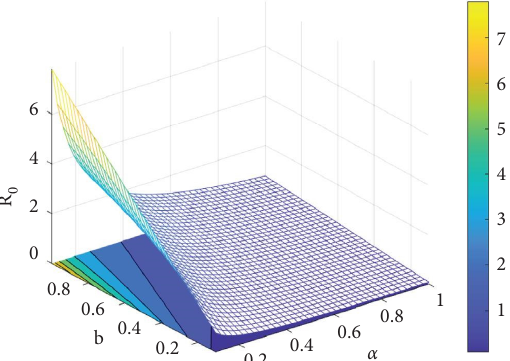
Figure 6: Te dynamics of Sensitivity Analysis with respect to parameters α and b with R